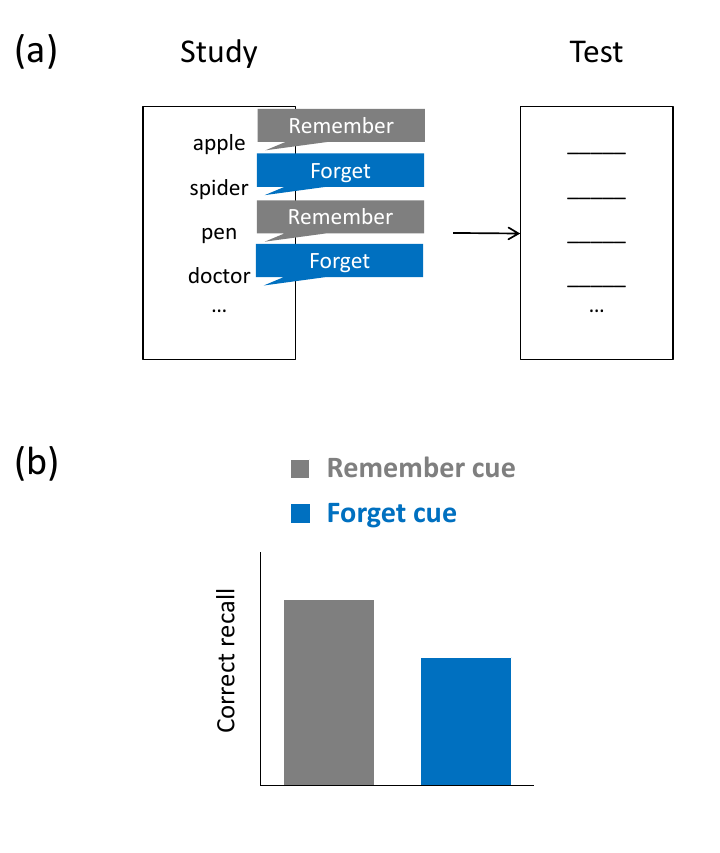
Figure 4. Item-method directed forgetting task. ( a ) Typical task: Participants study a list of items and, after studying each single item, they are either cued to remember or forget the item. On a subsequent retention test, subjects’ memory of all study items is assessed, irrespective of original cuing. ( b ) Typical results: Compared to subjects who were cued to remember list 1, subjects who were were cued to forget list 1 show impaired recall of list 1 and enhanced recall of list